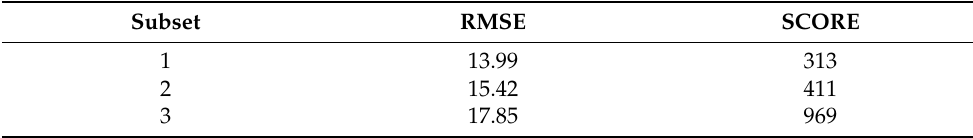
Table 11. Evaluation indexes for different feature subsets.